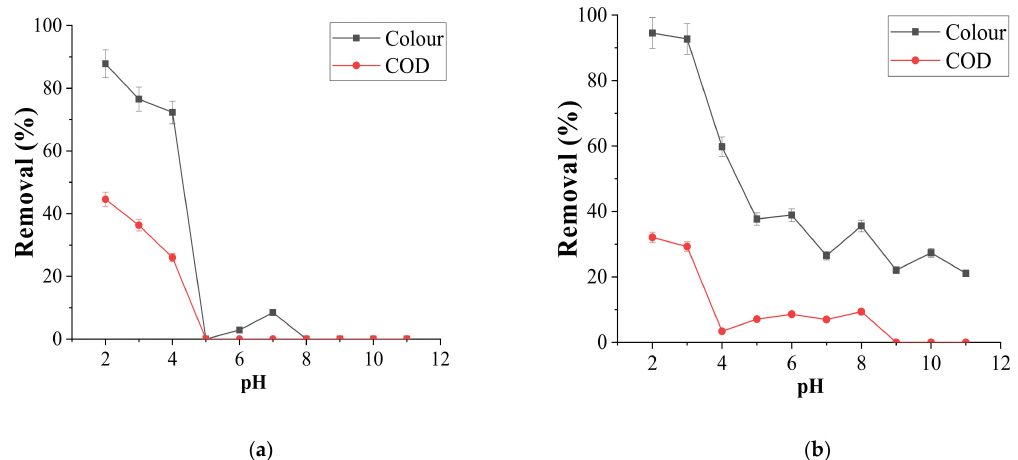
Figure 2. Influence of pH on the removal of colour and COD using ( a ) Rubber Seed (RS), ( b ) Polyacrylamide (PAM).